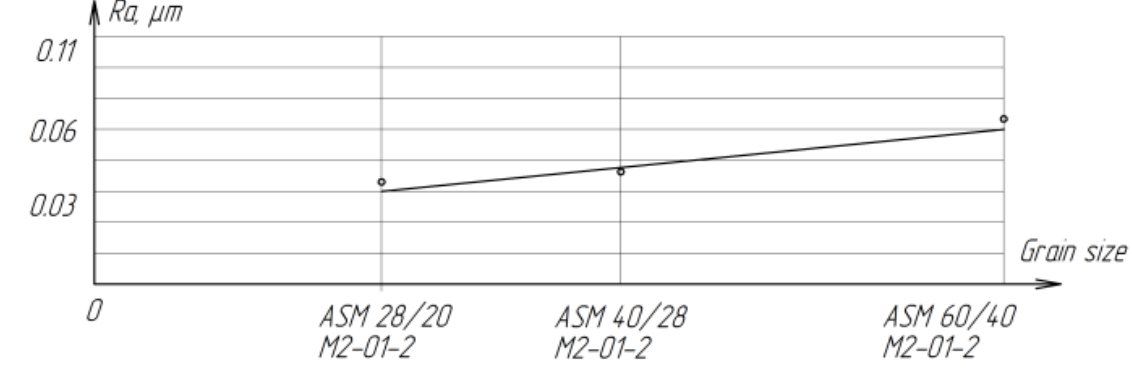
Figure 20. The effect of grain size on the roughness of ZrO 2 ceramics.